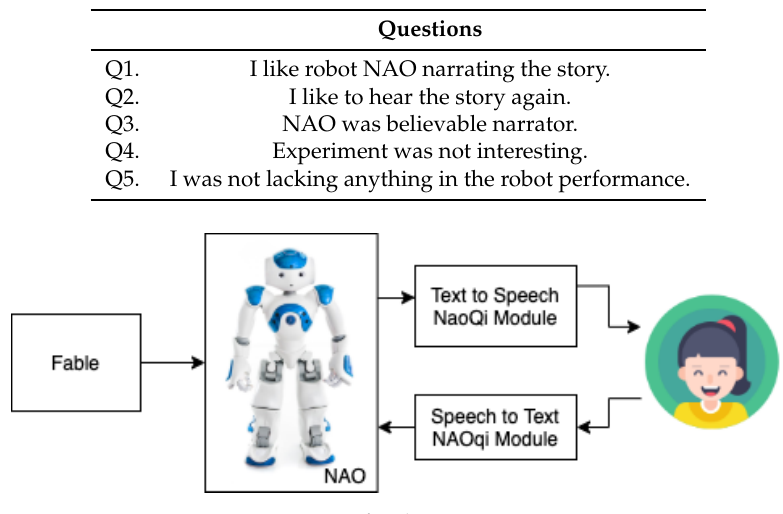
Figure 9. Setup for the experiment 1A.